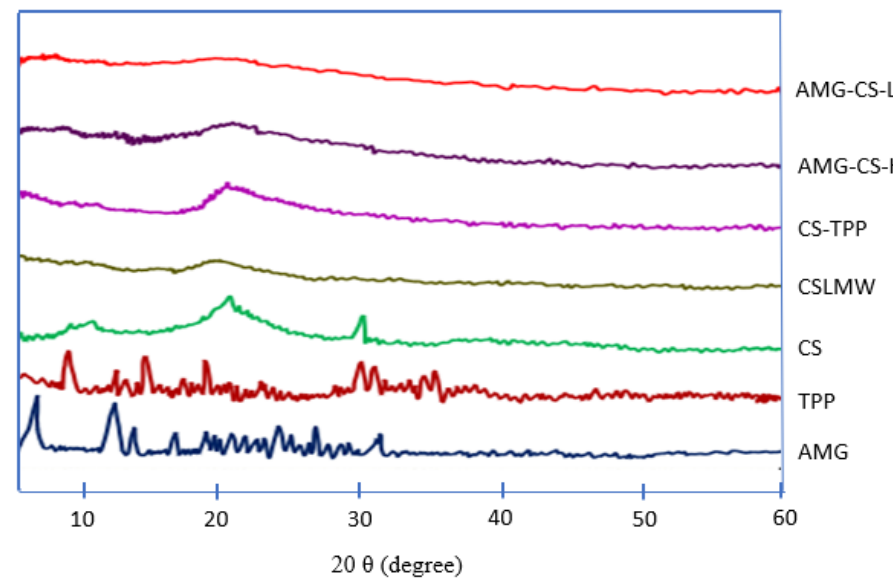
Figure 5. XRD spectra of AMG, TPP, CS, AMG – CS HMW, and AMG – CS